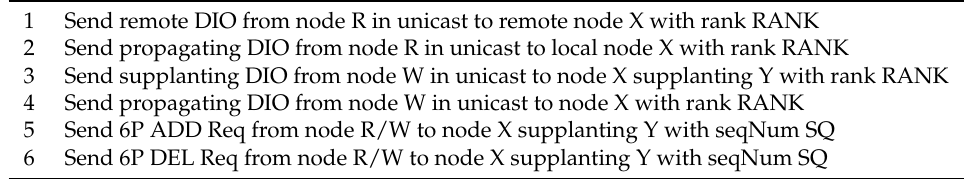
Table 1. Available primitives that determine the “ fake ” messages to be sent. W means Whisper node and R means root